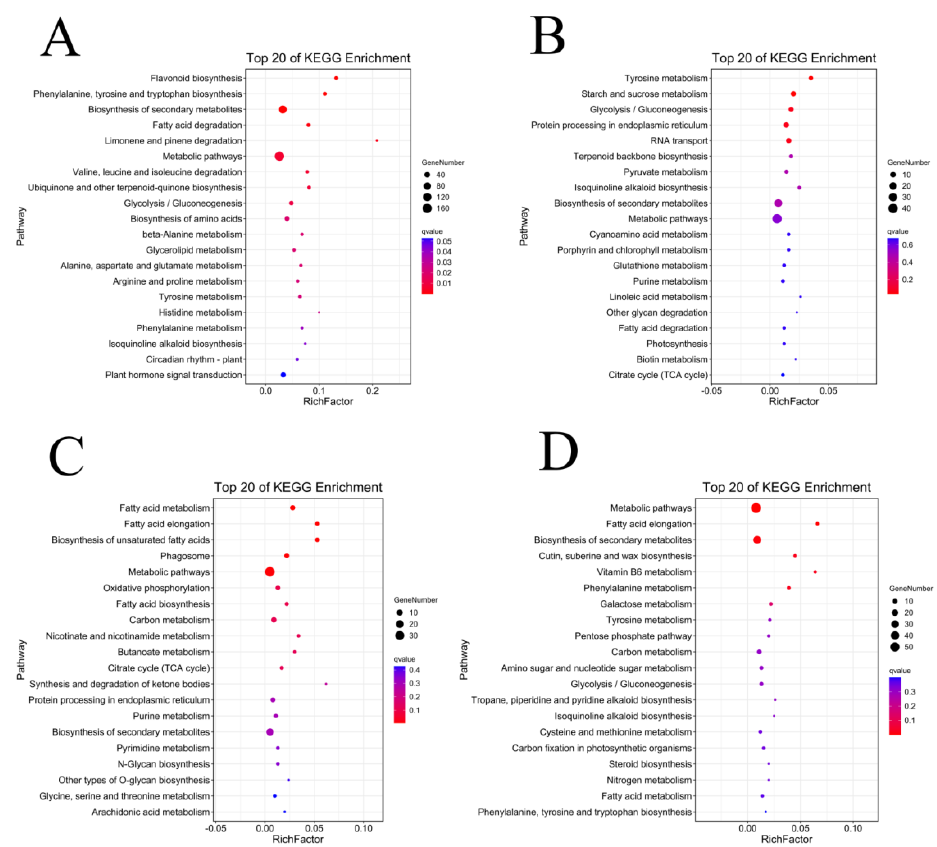
Figure 12. KEGG enrichment analysis of genes in target module (CSS386 and Sicala V-2): ( A ) MEblue module; ( B ) MEgreen module; ( C ) MEpink module; ( D ) MEred